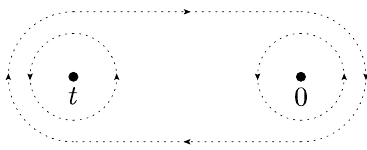
Figure 2 . Contours discussed for the double